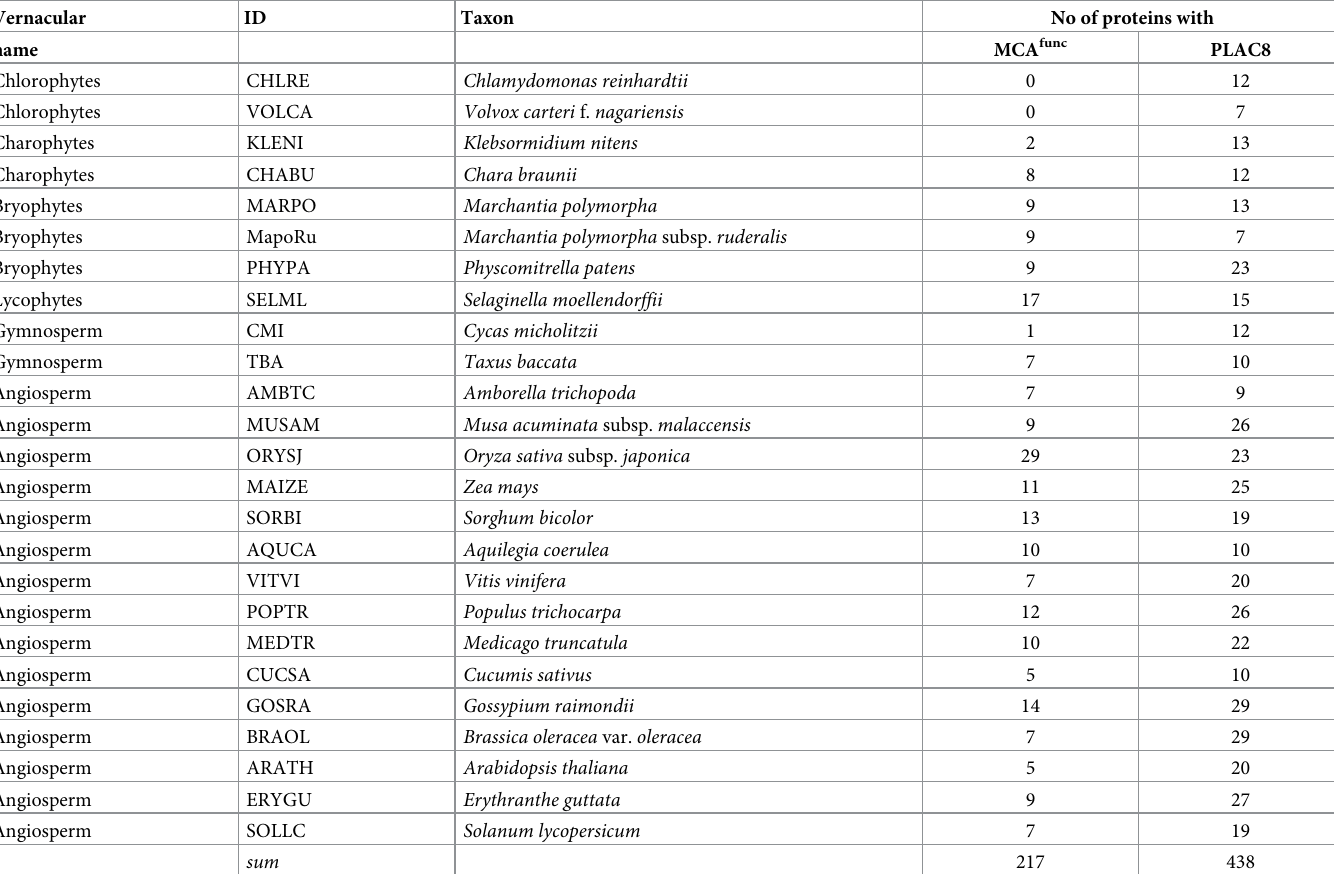
Table 1. Number of proteins found in proteomes. Result of profile HMM searches of MCA func and PLAC8 domains in proteomes of 25 taxa across viridiplantae. Num- ber of proteins retaining the MCA func or PLAC8 domains ( E value < 10 − 3 ) are listed and arranged following the Tree of Life (see S2, S7, and S8